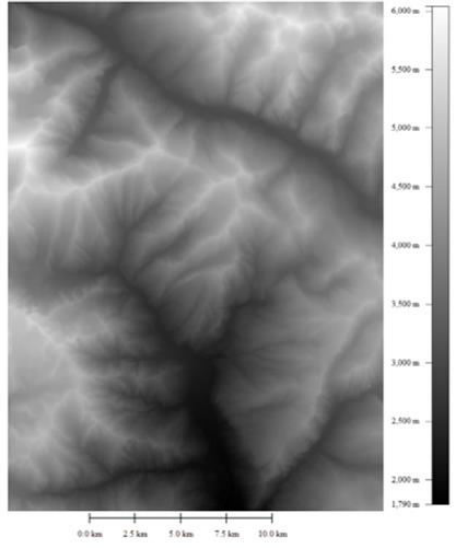
Figure 2: ADS80 High Spatial Resolution (1m Spatial Resolution) DEM